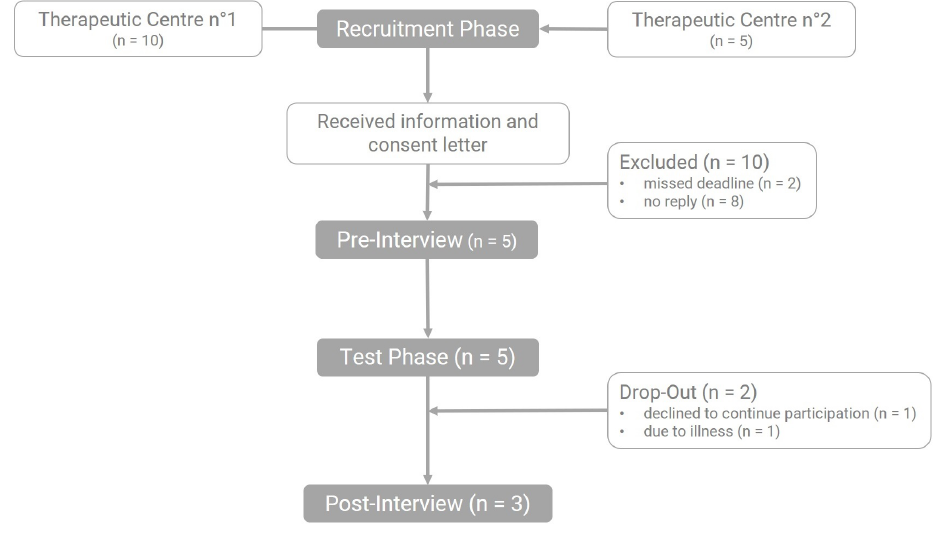
Figure 7. Participant flow